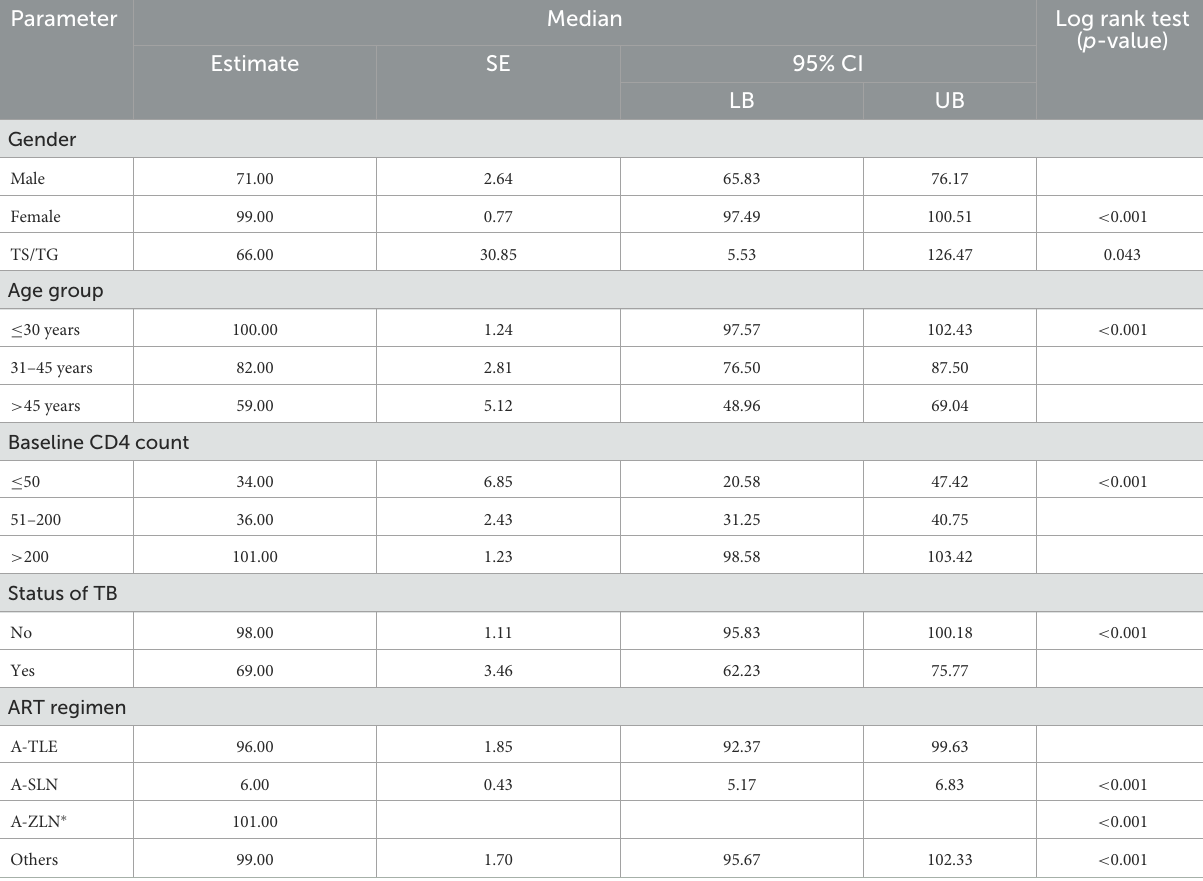
TABLE 4 Comparison of median survival times across various explanatory parameters.